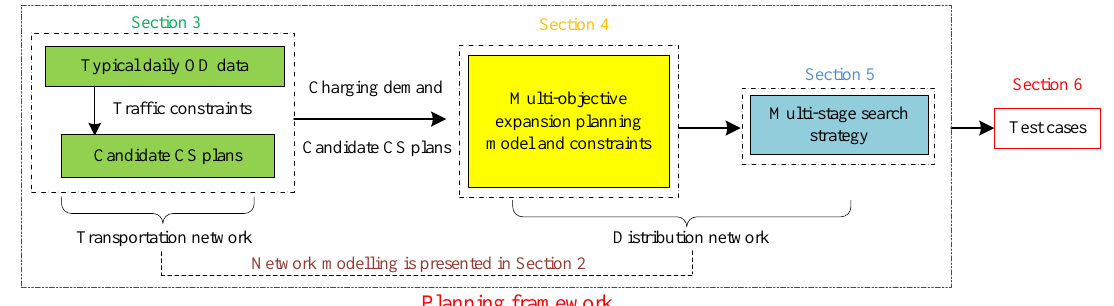
Figure 1. Integrated expansion planning framework.